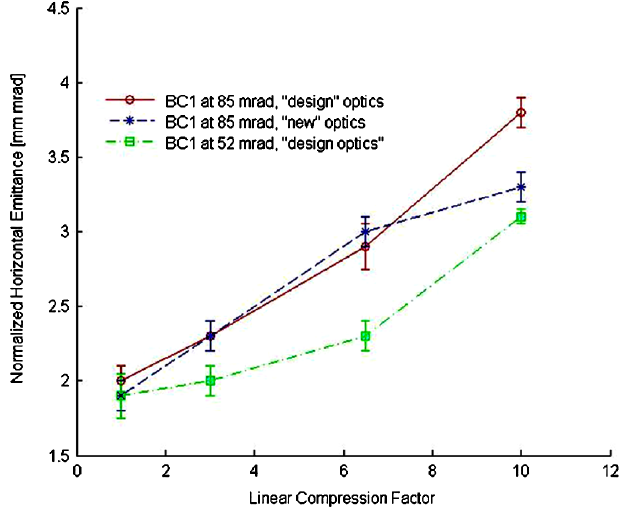
FIG. 9. Normalized horizontal emittance measured as a func- tion of the linear compression factor, C . For each line, BC1 is kept fixed while the L1 rf phase is moved far from crest to vary C . The lines refer to: original design optics with BC1 at 85 mrad bending angle (circle marker—solid red line); ‘‘new’’ optics with BC1 at 85 mrad (circle marker—dashed black line); origi- nal design optics with BC1 at 52 mrad (square marker—dashed green line).